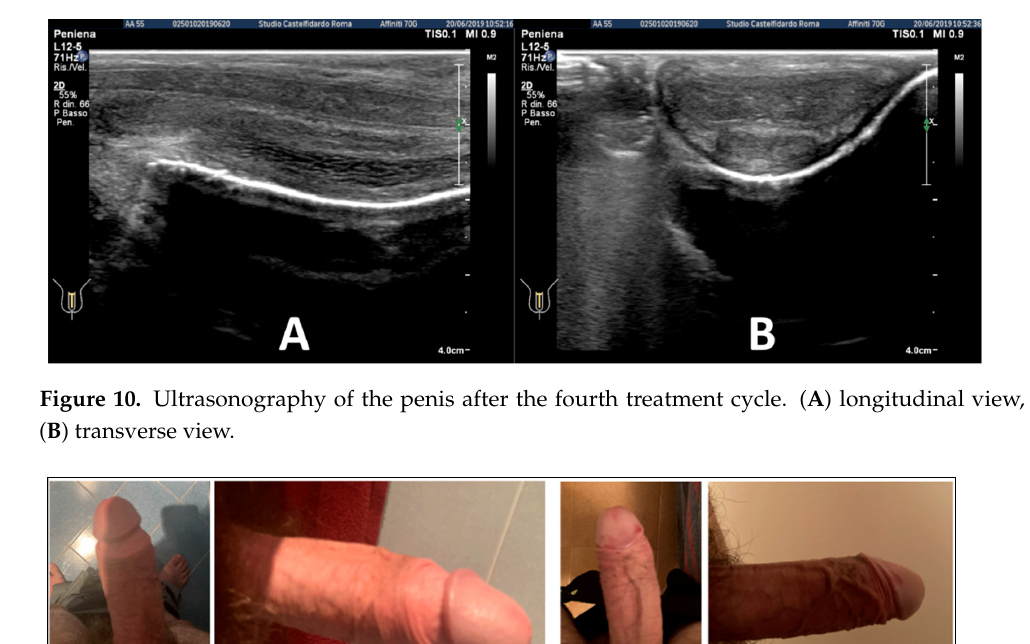
jections with pentoxifylline and extend the oral and topical treatments (unchanged for an